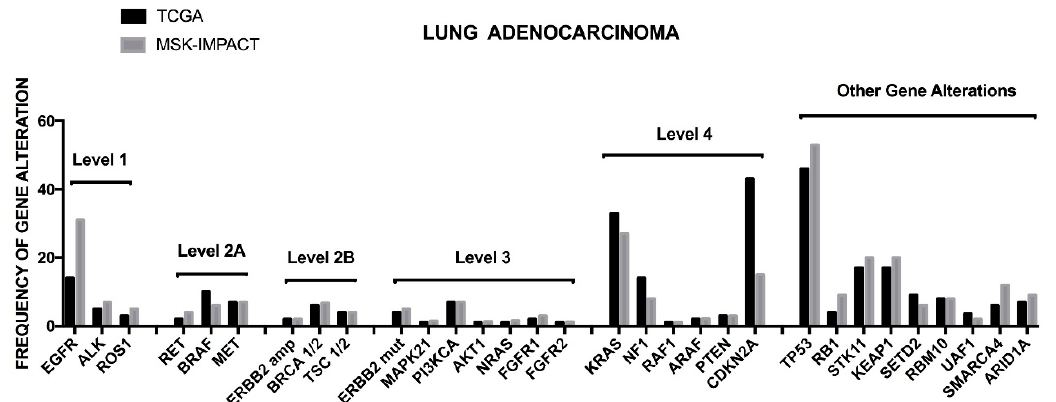
Figure 2. Frequency of main genetic alterations, subdivided into various levels according to the degree of therapeutic actionability of genetic events, in two groups of lung adenocarcinoma patients: TCGA data sets based on the analysis of non-metastatic patients and MSK-IMPAC data based on the analysis of recurrent/metastatic lung adenocarcinomas. Date are reported in [13,19].